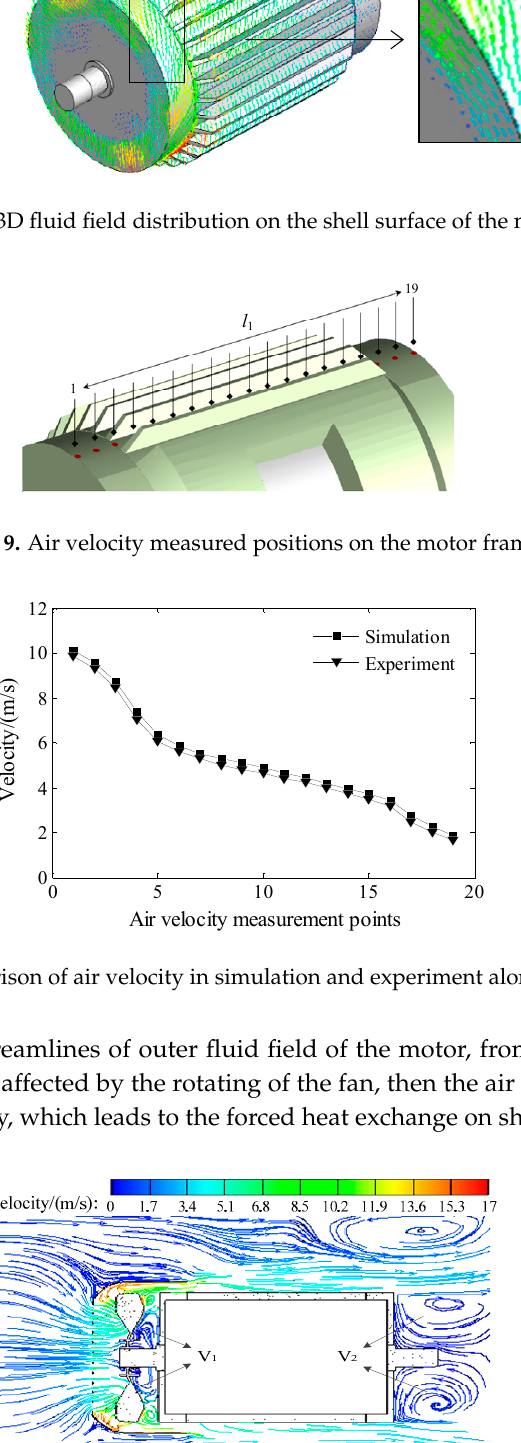
Figure 11. 2D streamlines of outer fluid field of the motor.